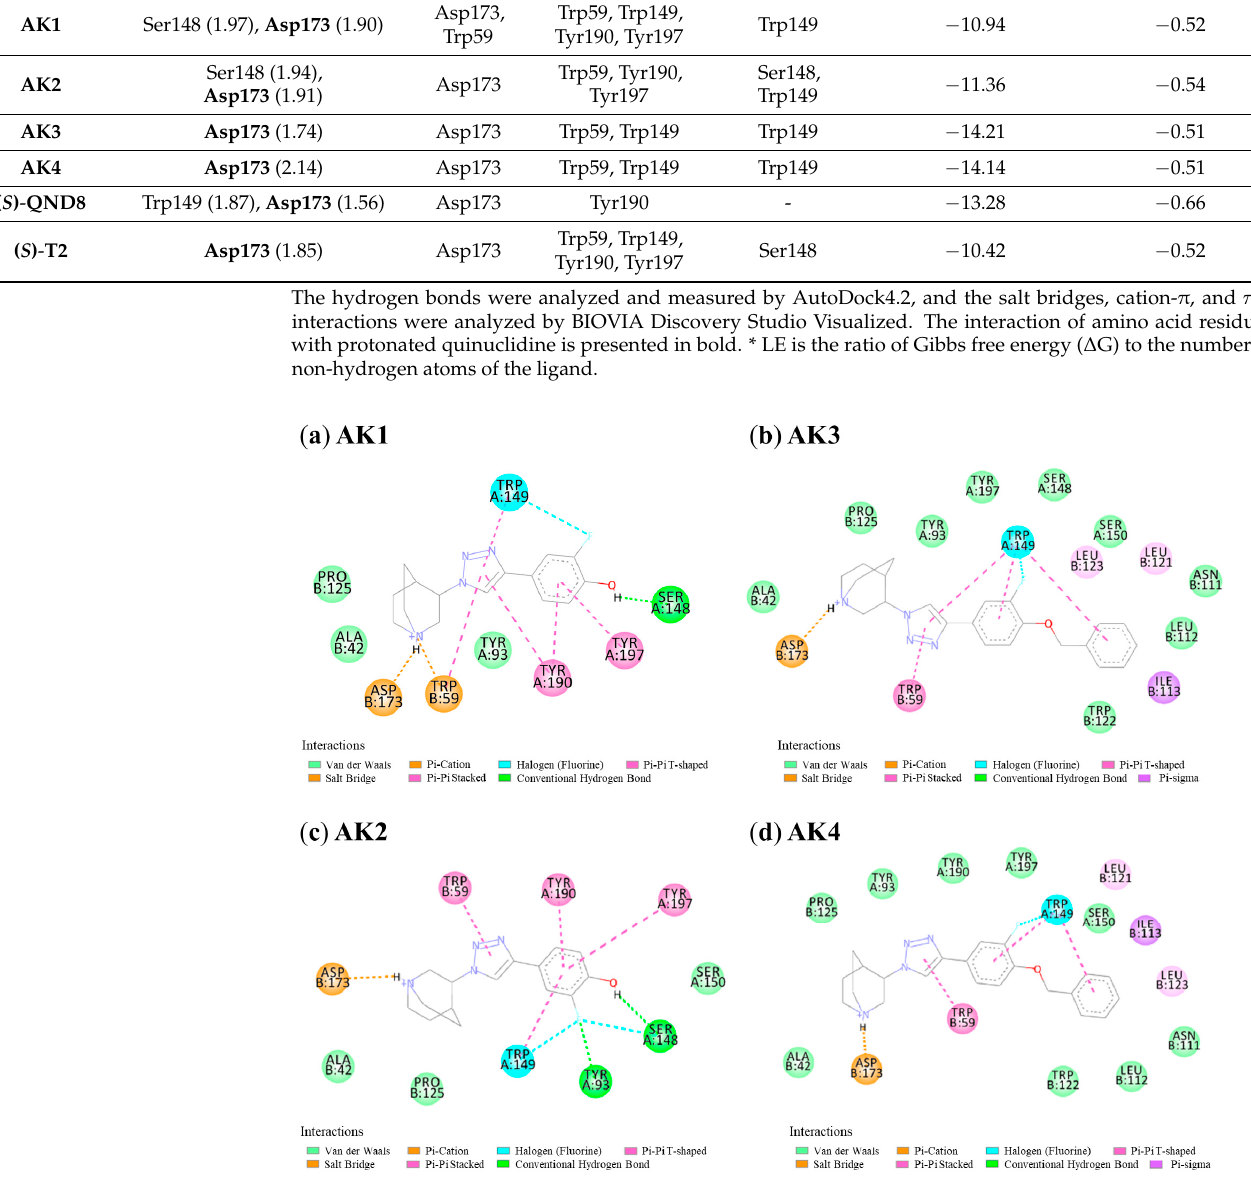
Figure 4. The binding interactions of ( S )-enantiomers ( a ) AK1 and ( b ) AK3 and ( R )-enantiomers ( c ) AK2 and ( d ) AK4 to α 3 β 4 nAChR. A and B indicated α 3 and β 4 subunits, respectively.